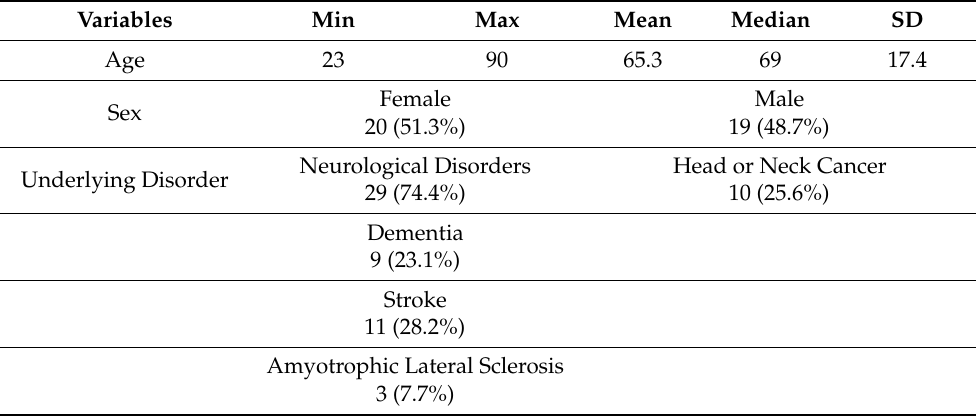
Table 1. Socio-demographic characteristics of the participating subjects from the